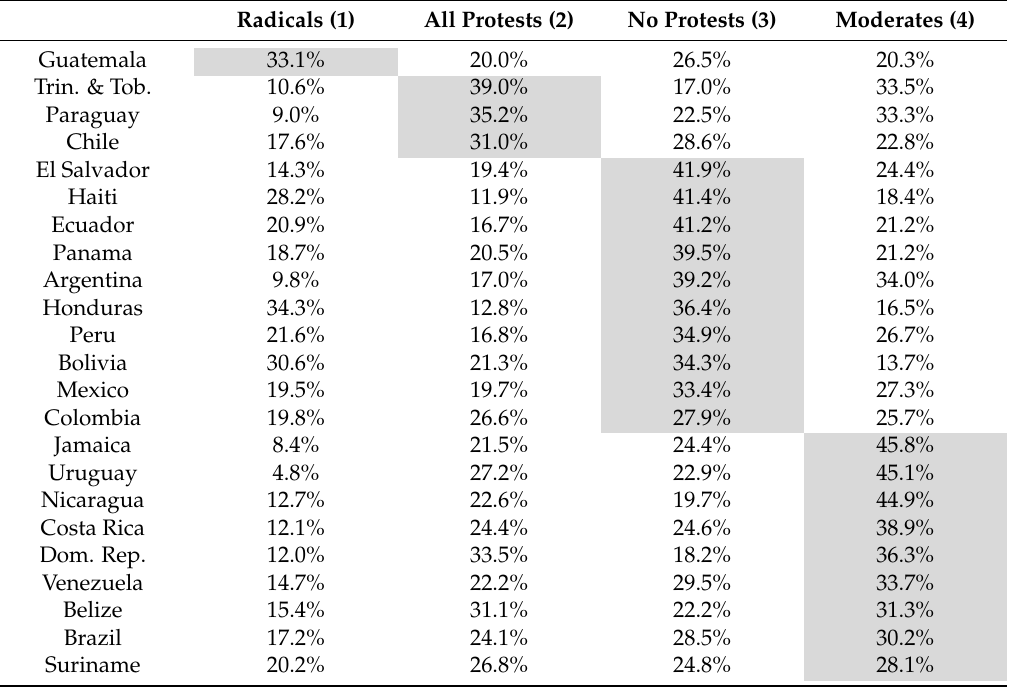
Table 2. Countries by